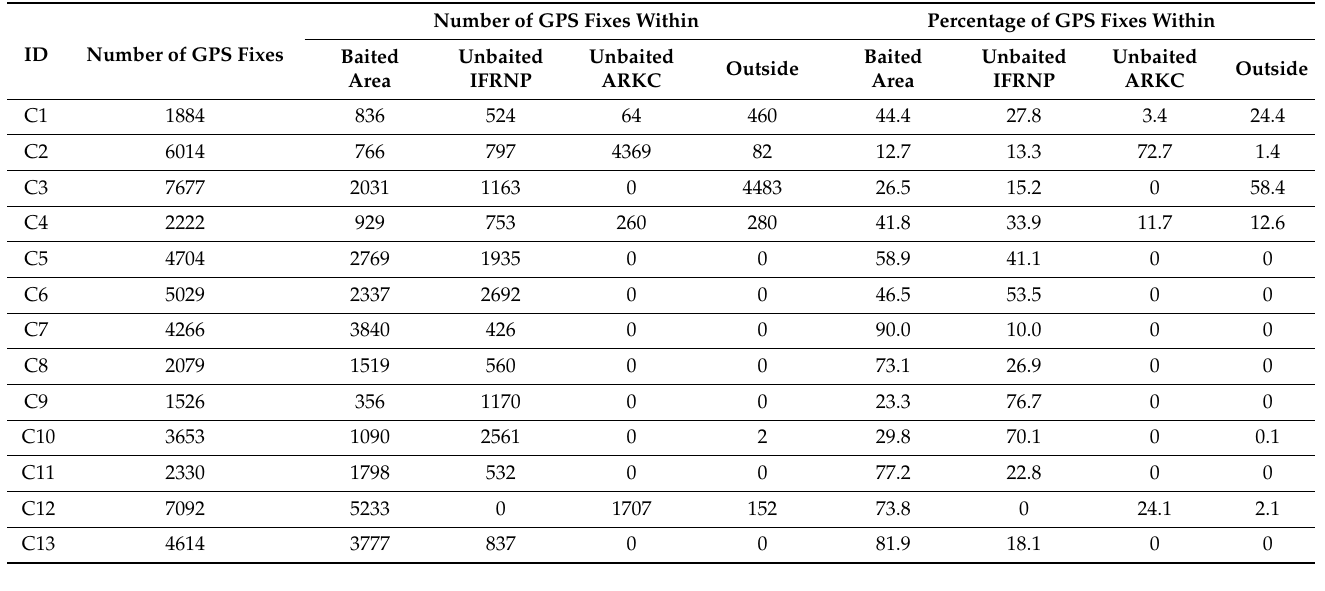
Table 3. GPS points of the collared feral cats that fell within the baited zone, the Ikara-Flinders Ranges National Park (IFRNP), Arkaba Conservancy (ARKC) or outside of the National Park and Arkaba.